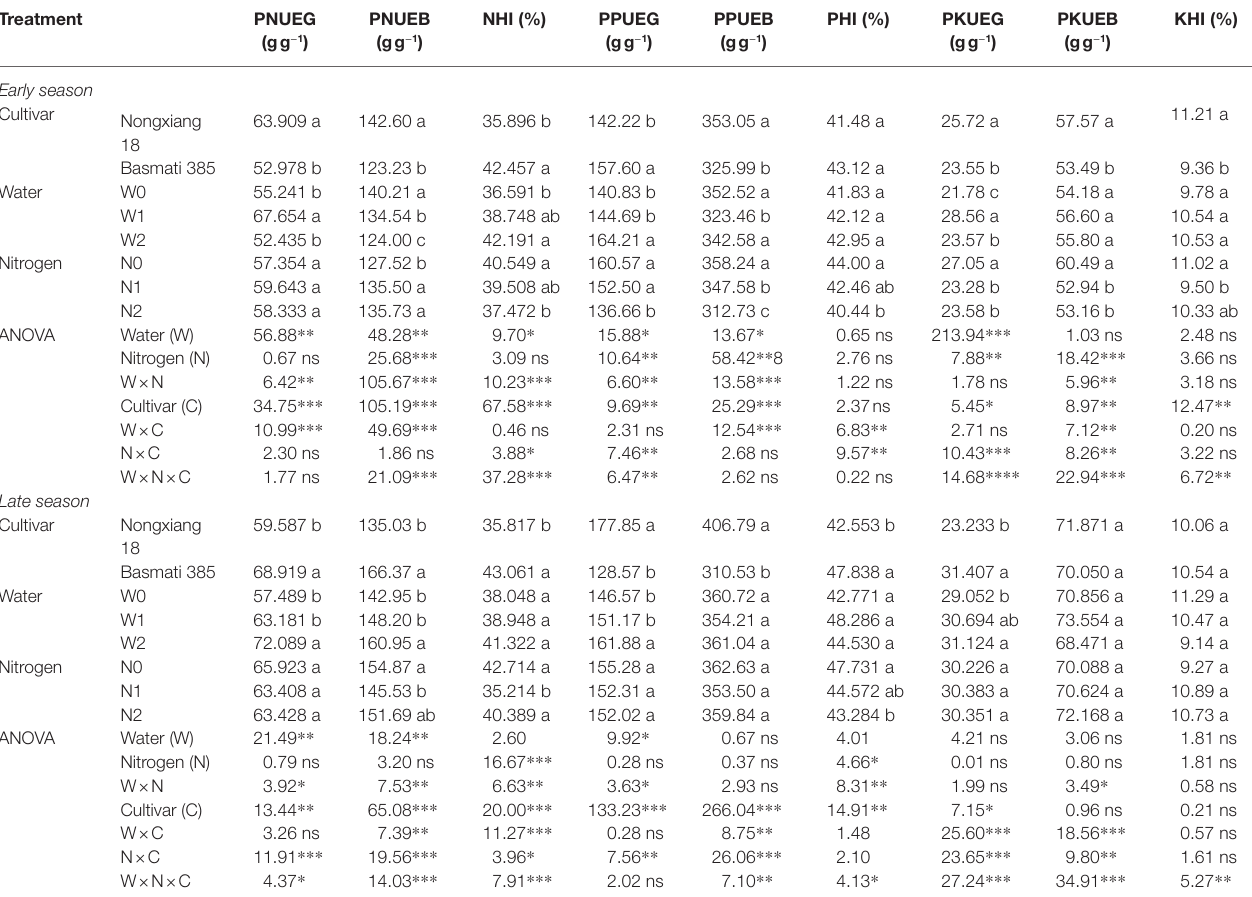
TABLE 7 | Physiological N, P and K use efficiency for grain and biomass and N, P, and K harvest index as affected by water, nitrogen, and cultivar in the early and late season of double rice cropping system in South China.